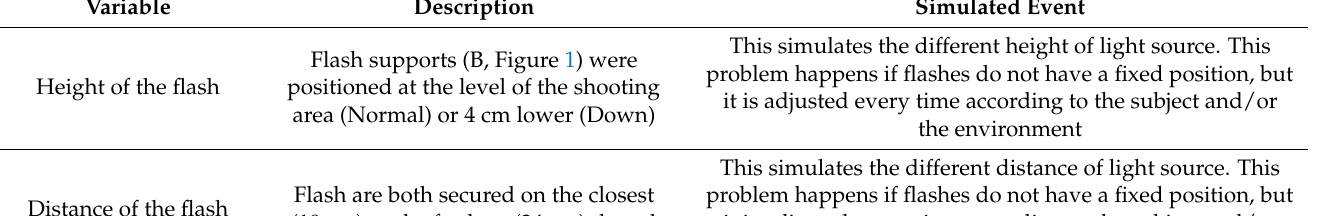
Distance of the